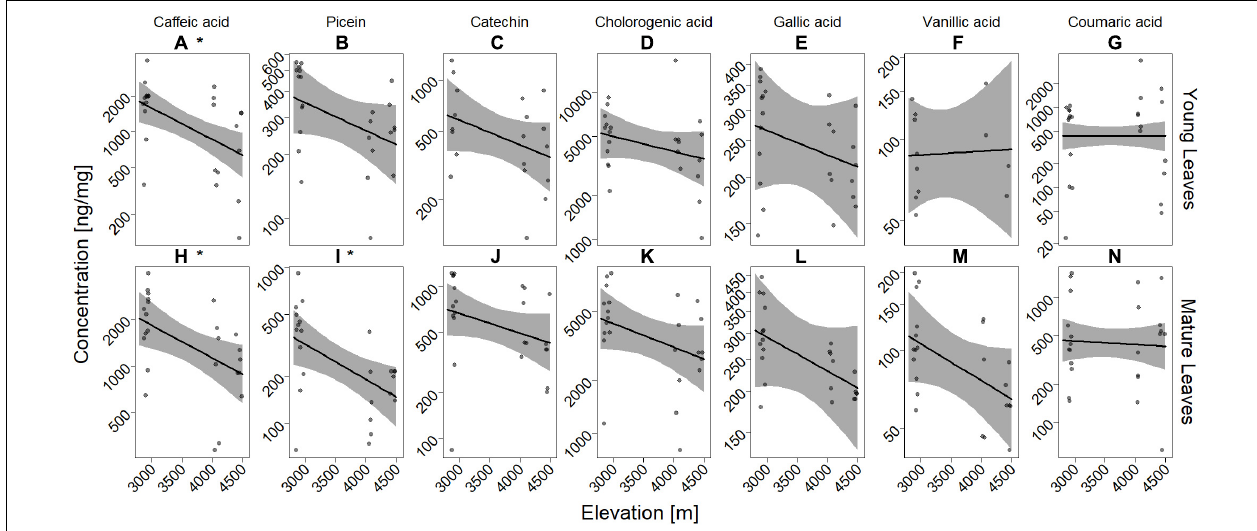
FIGURE 3 | Concentration of phenolic defense compounds decreases with elevation in young (A–G) and mature (H–N) leaves. Solid lines show the estimated marginal means from the GLM and the gray-shaded area shows the 95% confidence interval. Raw data is displayed as dots (each n = 24), slightly jittered to avoid overlap. Significant effects are highlighted with common asterisk notation next to the panel label. The concentration axis was logarithmized.